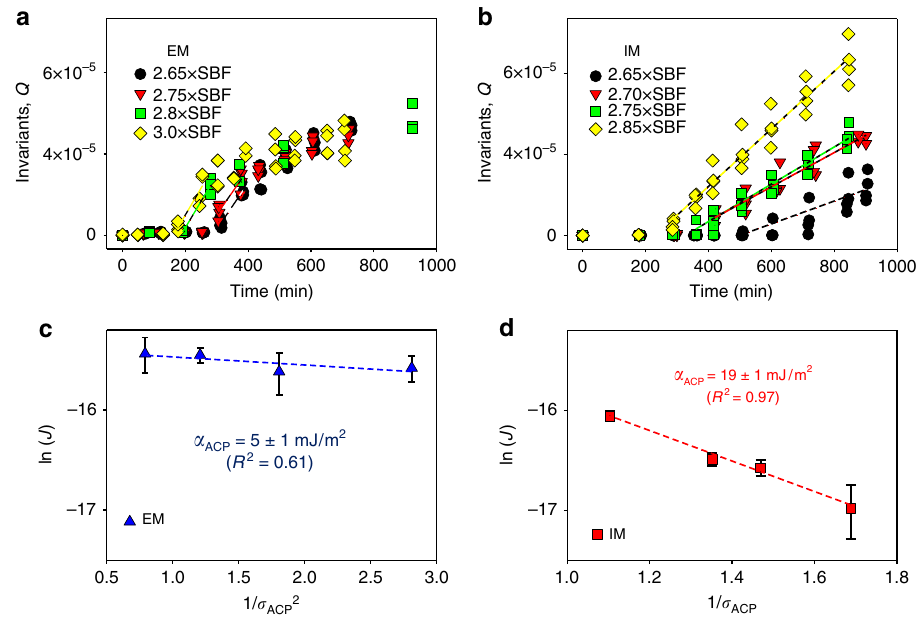
Fig. 3 Interfacial energy relationships during the nucleation of calcium phosphate within collagen fi brils. a, b Evolution of the invariant, Q , from in situ SAXS measurements of collagen matrices in different simulated body fl uid (SBF) solutions without pAsp ( a , representing extra fi brillar mineralization, EM) and with pAsp ( b , representing intra fi brillar mineralization, IM). The slopes of the dotted lines indicate the nucleation rate, J . For the EM case, the initial J values were taken from the maximum slopes between two time intervals. Only Q within the range of q = 0.05 – 0.3 Å − 1 (corresponding to plate-like particles) were calculated. c , d Interfacial energies for ACP nucleation ( α ACP ) during EM and IM, calculated from the relationship between J and supersaturation with respect to ACP, σ ACP (see Table 1 for the equations). Error bars in the symbols indicating ln( J ) are standard errors of the estimates, obtained from the regressions between Q and time (from a , b ). Error ranges for α ACP values for EM and IM are standard errors of the estimates for regressions between ln( J ) and 1/ σ 2 , and between ln( J ) and 1/ σ ,